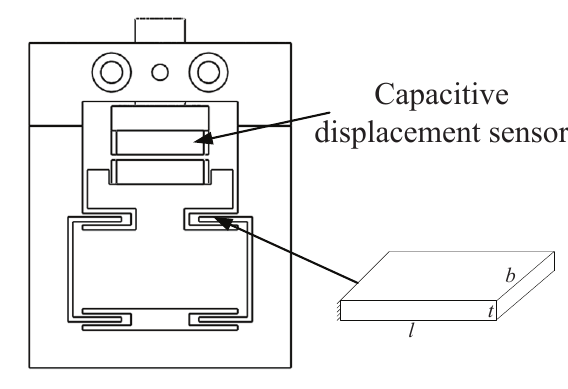
Figure 5. Structure of the force-displacement sensing module.